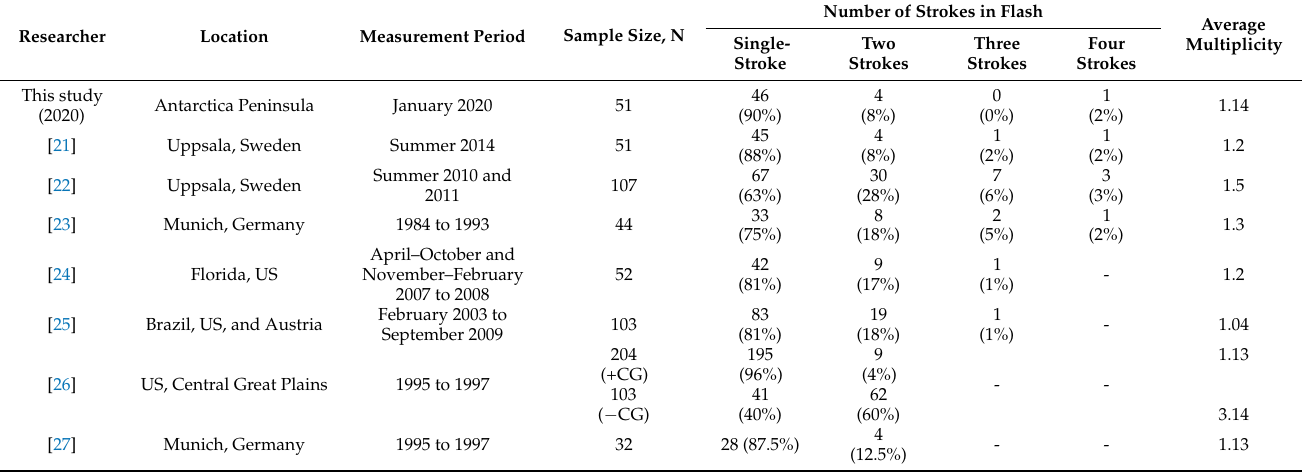
Table A3. The distribution of +CG flashes with different number of